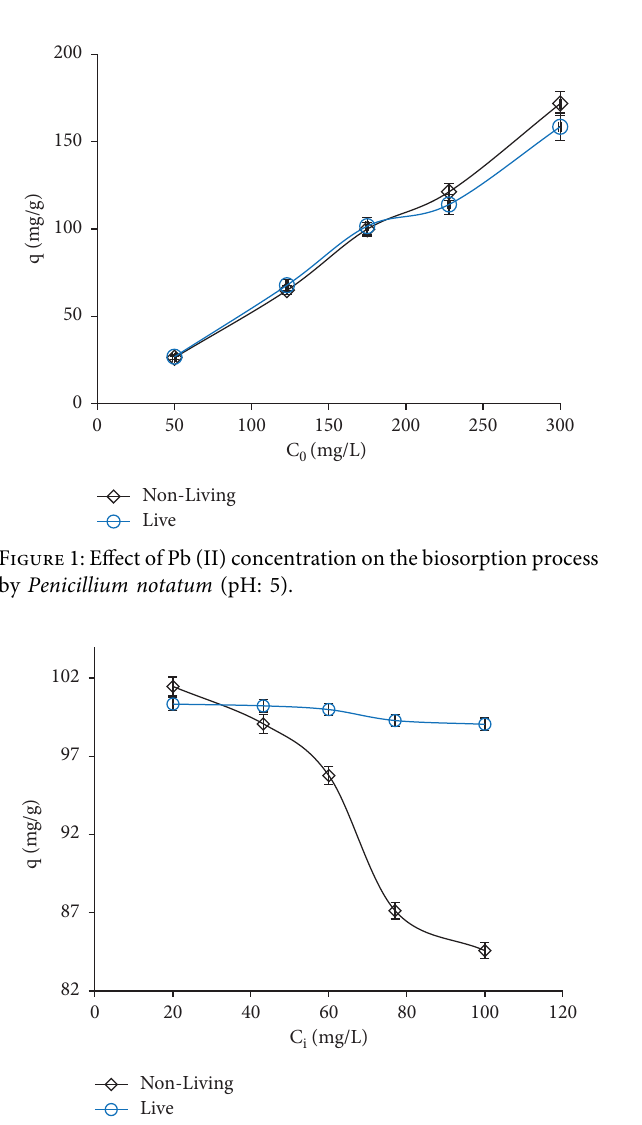
Figure 2: Efect of ionic intensity on the uptake of Pb (II) by Penicillium notatum (pH: